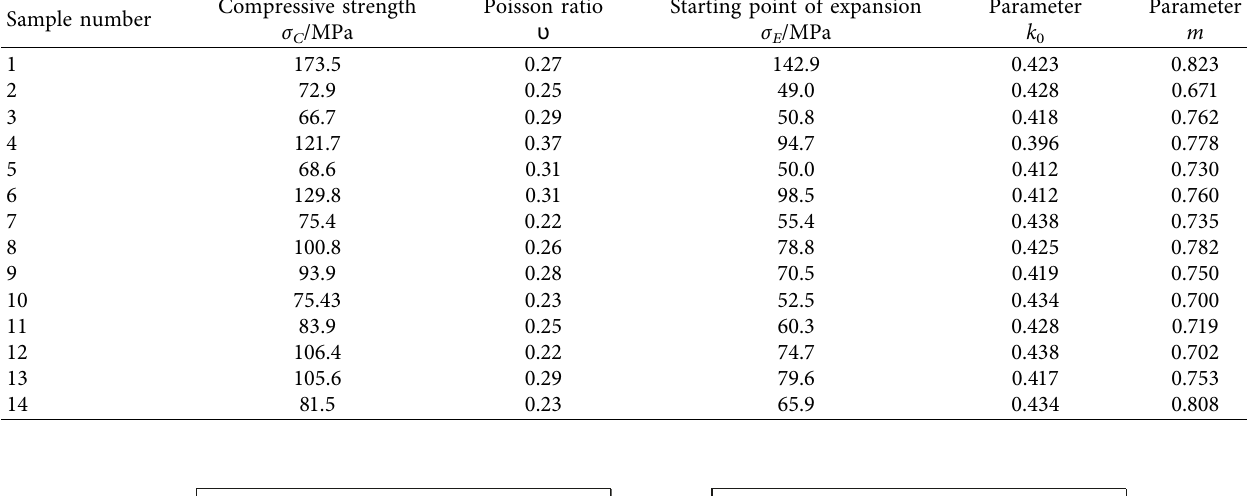
Table 4: The uniaxial compression test results and material parameters of granite.